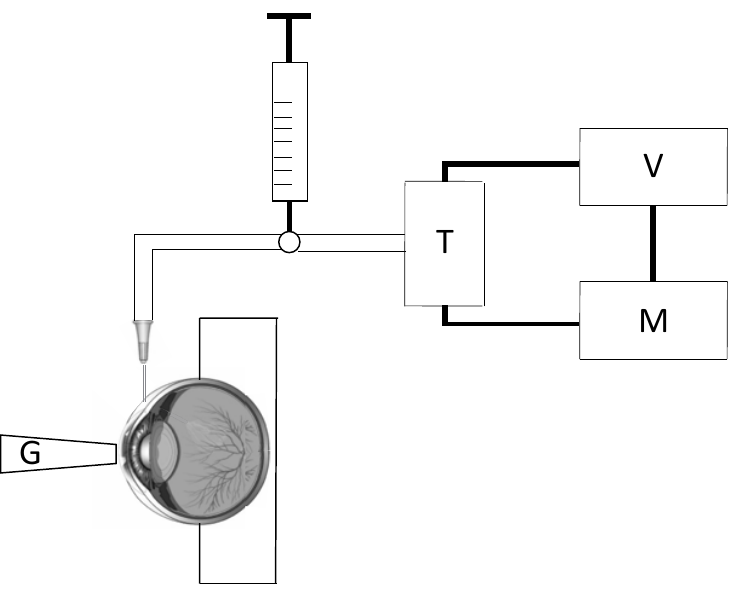
Figure 1. Scheme of the experimental setup used to measure the intraocular pressure, IOP. G: Goldmann applanation tonometer, T: pressure transducer, V: power supply, M: multimeter.